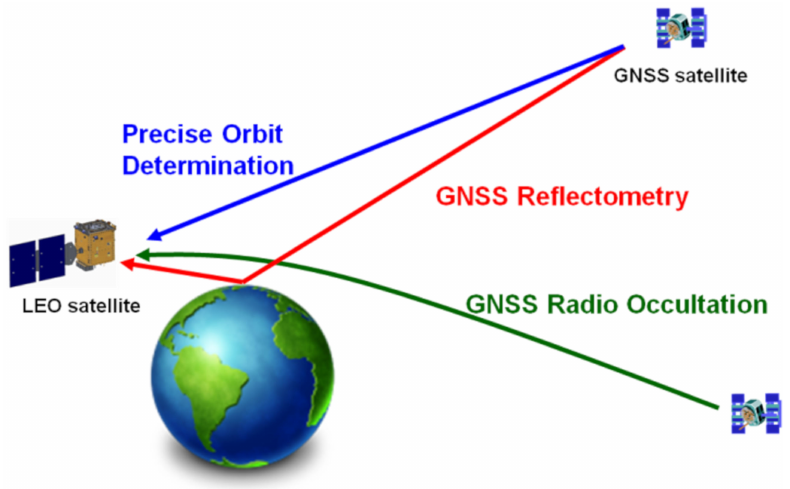
Figure 1. The space applications of global navigation satellite systems (GNSS).